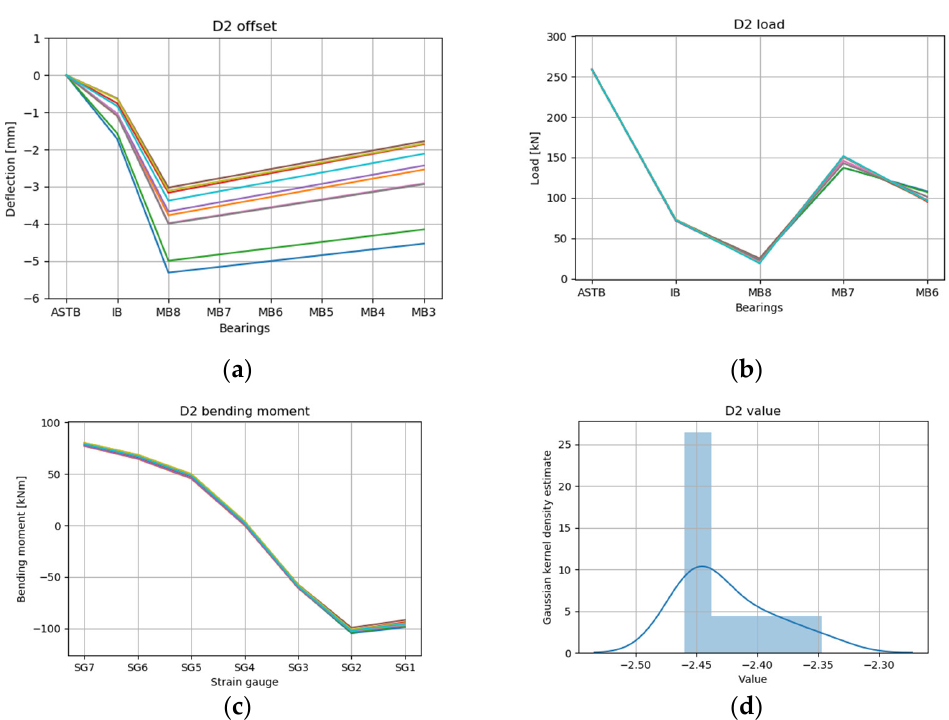
Figure 18. RL results for draft condition D2 top 10 cases: ( a ) offset, ( b ) load, ( c ) bending moment, and ( d ) value.